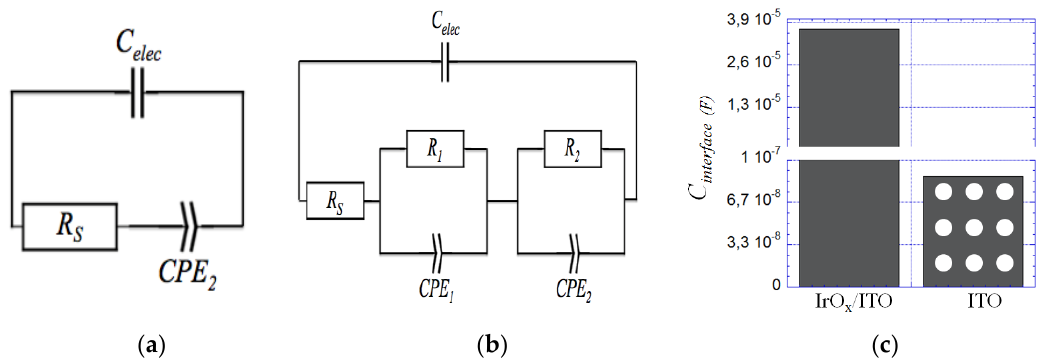
Figure 3. Equivalent circuit models used for ( a ) ITO-IDEs and ( b ) IrO x /ITO-IDEs. ( c ) Pseudocapacitance of the electrode-cell culture medium interface for ITO and ITO coated with IrO x electrodes. C elec represents the capacitive behavior of the electrode fingers; CPE 1 and R 1 model the IrO x on the surface of ITO while CPE 2 and R 2 are associated with the interface between the electrode and the cell culture